Question: What kind of plot is shown here?
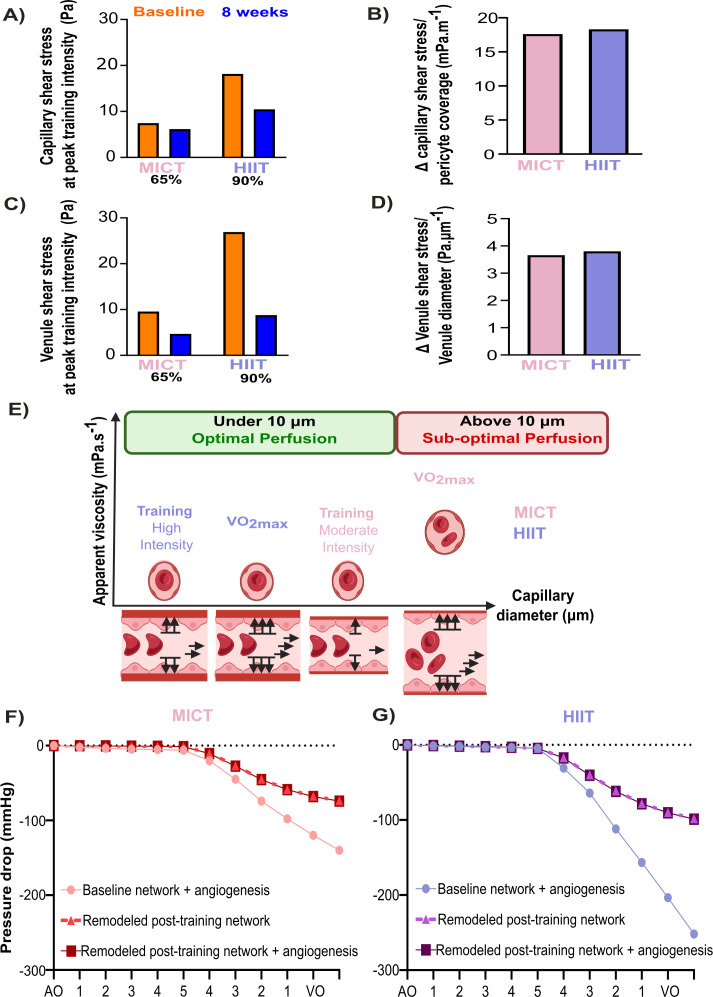
Answer: line